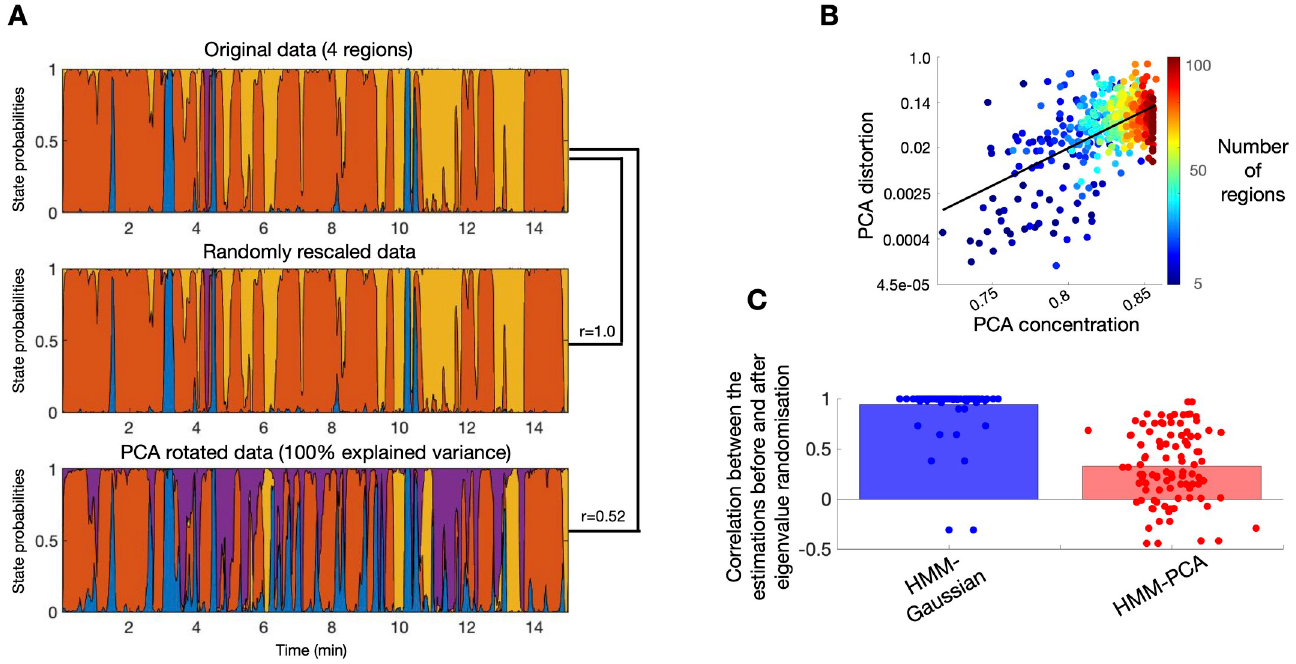
Fig 2. HMM-PCA outperforms the HMM-Gaussian and Mix-PCA approaches on synthetic data. A . Example of how the different models recover the ground- truth state time courses. B . Comparative accuracy between HMM-PCA (Y-axis), HMM-Gaussian (X-axis, red) and Mix-PCA (X-axis, blue). Each dot represents one repetition of the simulations. Accuracy is measured in terms of how well each method recovered the ground-truth state time courses. Permutation-based statistical testing revealed that HMM-PCA was always significantly more accurate than the other approaches (p < 0.001).